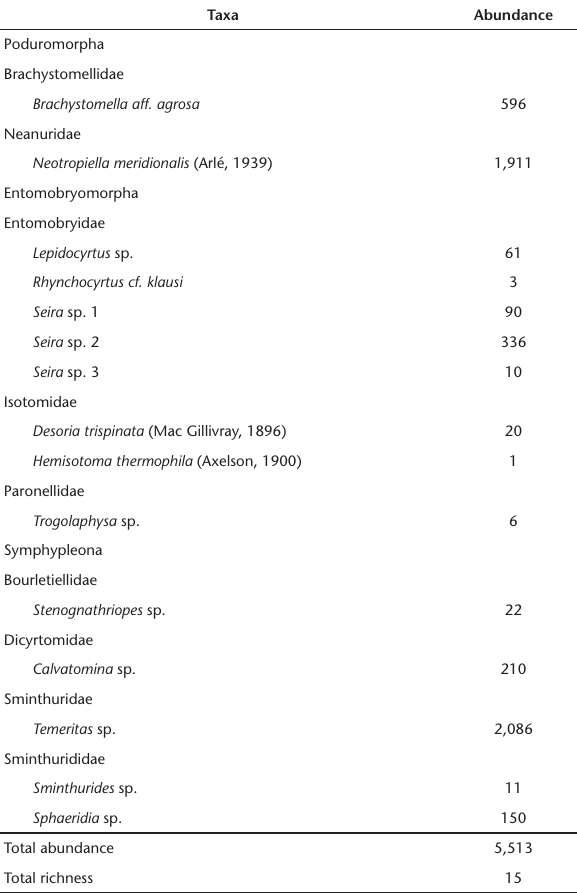
Table 1. Epiedaphic Collembola taxa recorded from João Câmara, Rio Grande do Norte, Brazil, in July 2011 (rainy period) and November 2011 (dry period) and their respective